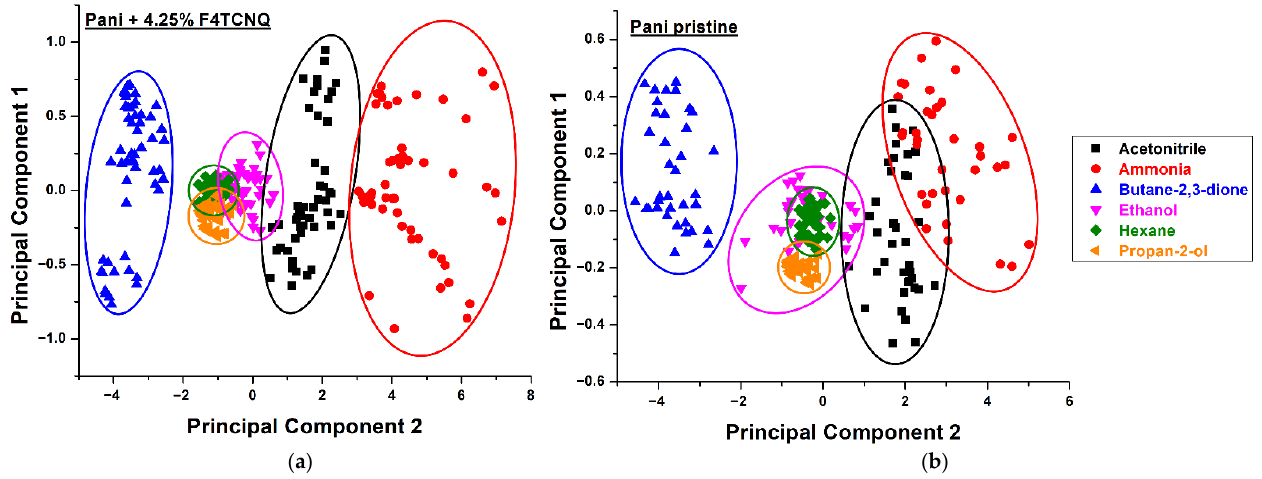
Figure 5. PCA for six different analyte gases measured with ( a ) eight F4TCNQ-doped polyaniline sensors and ( b ) six undoped polyaniline sensors.